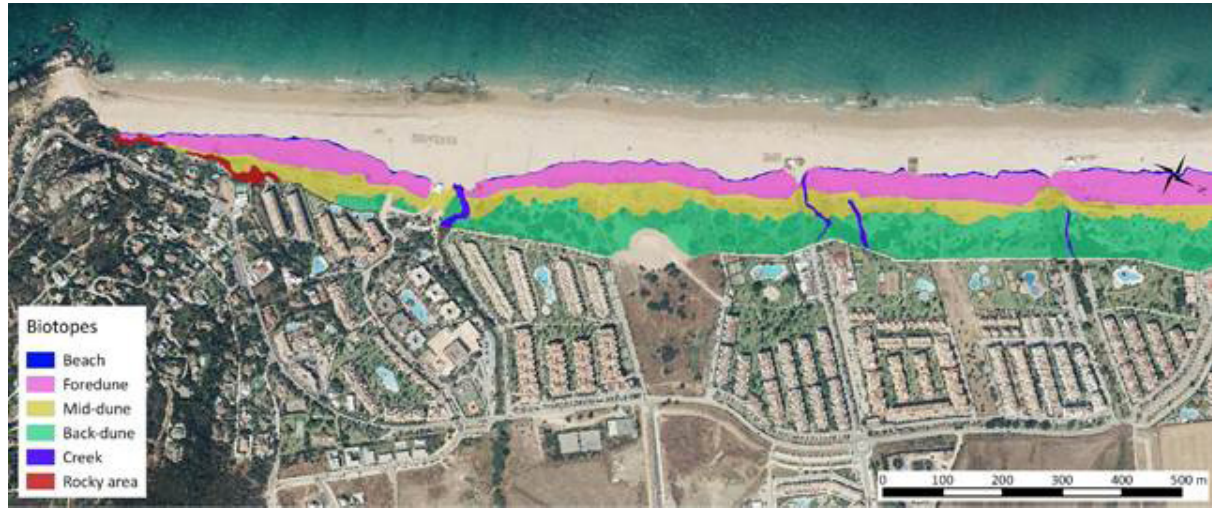
Figure 2. Distribution map of the habitats